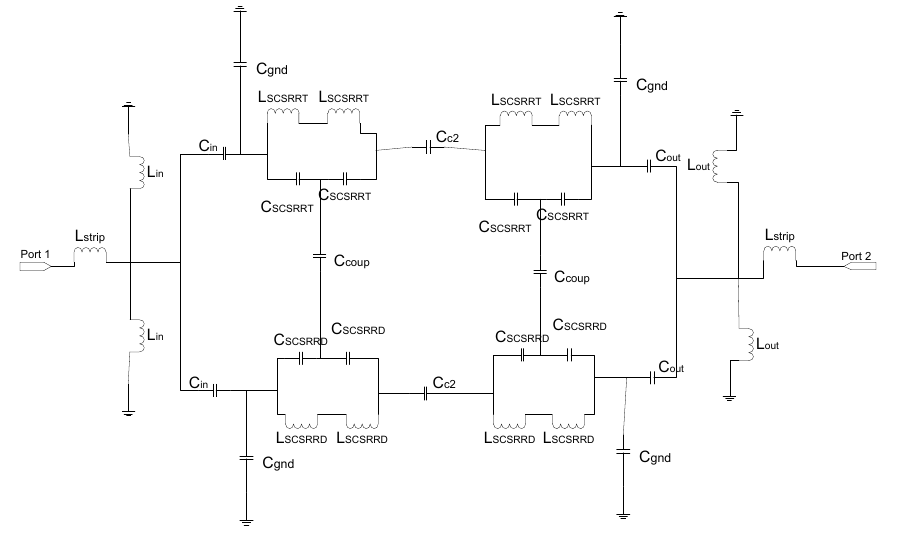
Figure 26. Equivalent circuit model for the multilayer stripline filter.